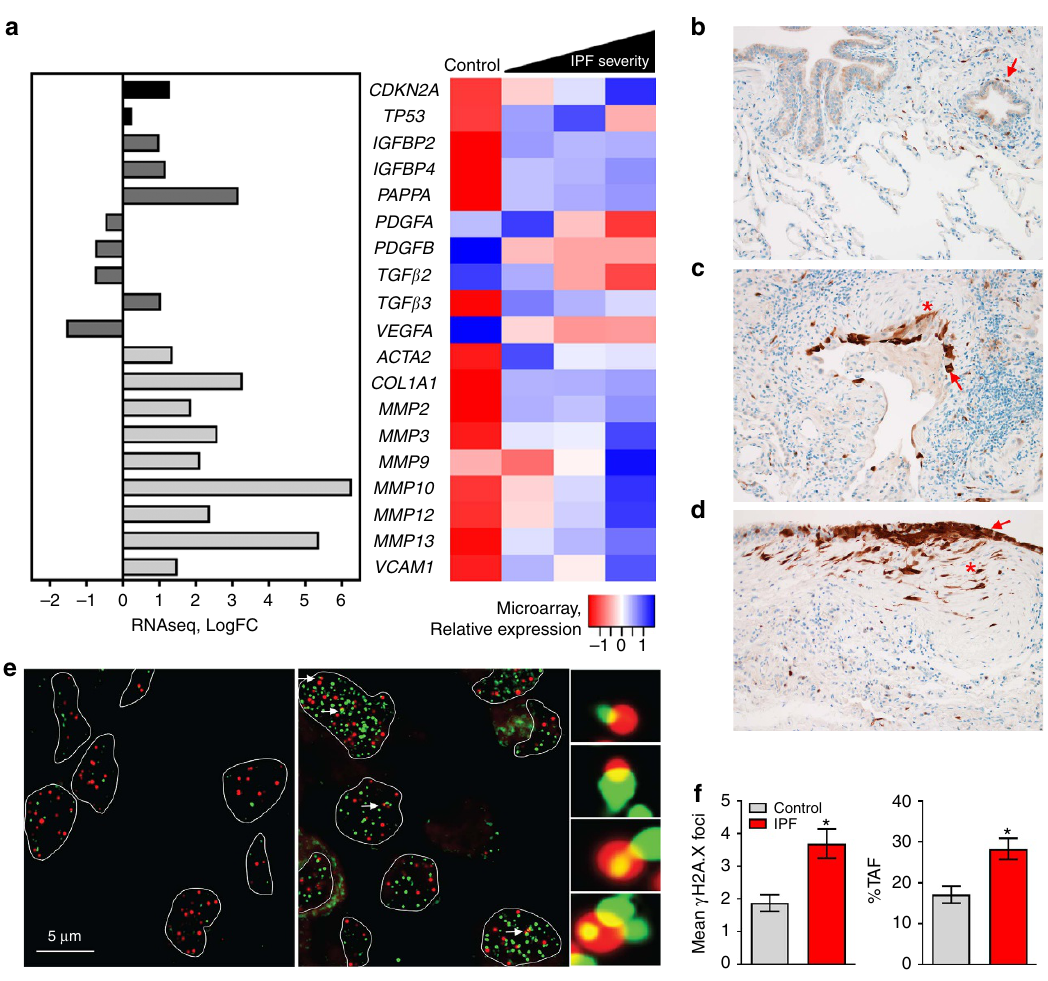
Figure 1 | Biomarkers of cellular senescence in human IPF. ( a ) Transcriptional changes corresponding to senescence effectors (black), SASP growth factors (dark grey) and SASP matrix remodelling (light grey) genes that were identified in independent RNAseq (control n ¼ 19, IPF n ¼ 20) and microarray human lung IPF versus control data sets are shown. IPF samples analysed by microarray were severity classified by FVC as low ( Z 80%; n ¼ 17), moderate (50–80%; n ¼ 60) or severe ( o 50%; n ¼ 16) and compared with control ( n ¼ 64) ( q o 0.05 for both RNAseq and microarray). Human lung tissue sections were IHC stained for p16 in b control and ( c , d ) IPF lung samples with ( c ) fibroblastic foci and ( d ) honeycomb lung depicted. p16-positive fibroblasts (stars) and epithelial cells (arrows) are indicated ( (cid:3) 200 images). ( e ) Control (left panel) and IPF (right panel) lung sections were analysed for frequencies of DNA damage foci ( g H2A.X, green) and telomere immuno-fluorescence in situ hybridization (red) within alveolar compartments. Arrows indicate g H2A.X foci co-localizing with telomeres (TAF) (scale bar, 5 m m), shown at higher magnification on the right (images are from maximum intensity projection). ( f ) Mean number of g H2A.X foci (left) and percentage of cells containing at least one TAF (right) were determined through quantification of Z -stack images with at least 100 cells per sample ( (cid:3) 100 images) (mean ± s.e.m.; control n ¼ 10 (grey), IPF n ¼ 27 (red); t -test * P r